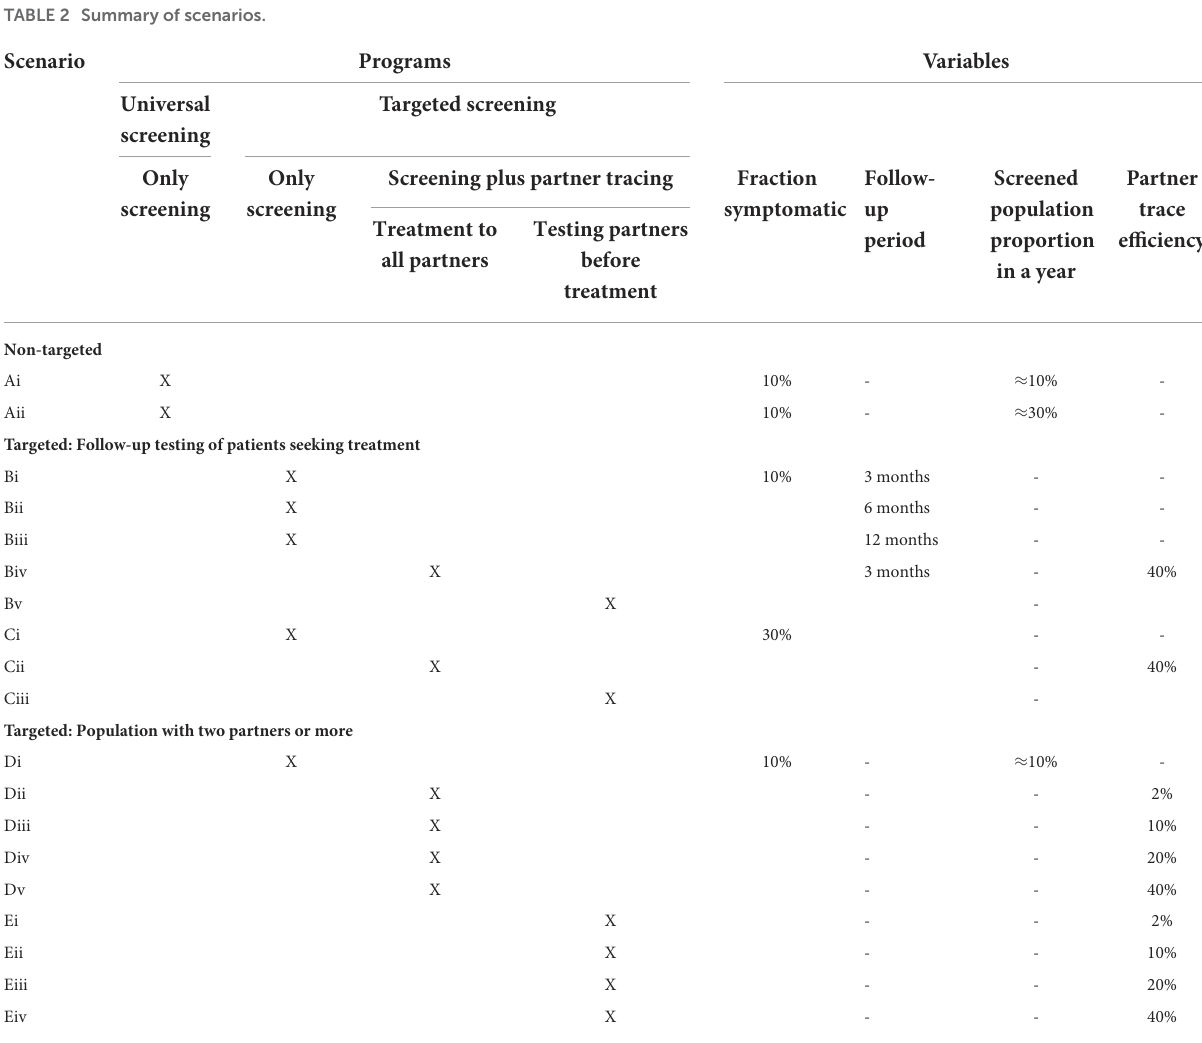
TABLE 2 Summary of